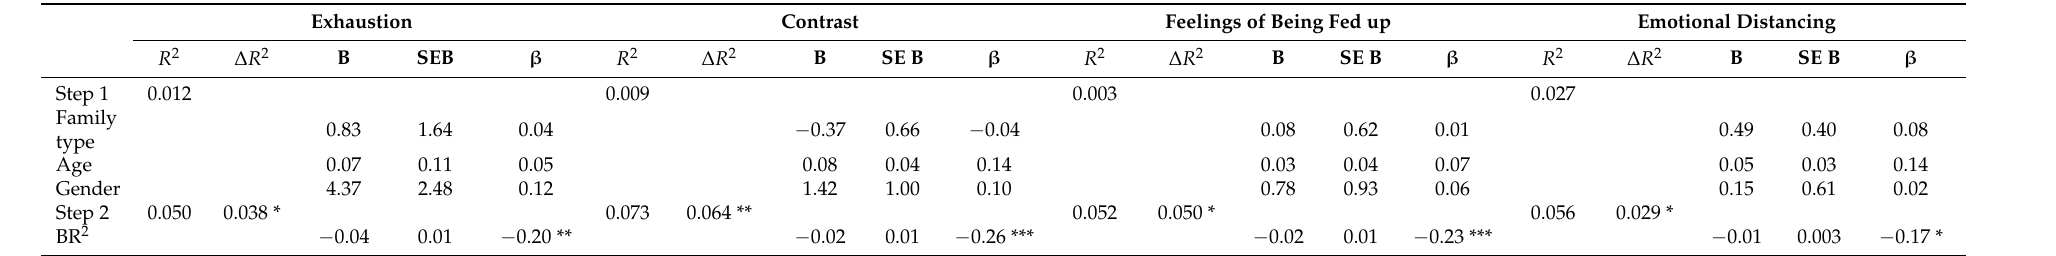
Table 3. Hierarchical Regression Analyses for Variables Predicting Parental Burnout Subscales (Study